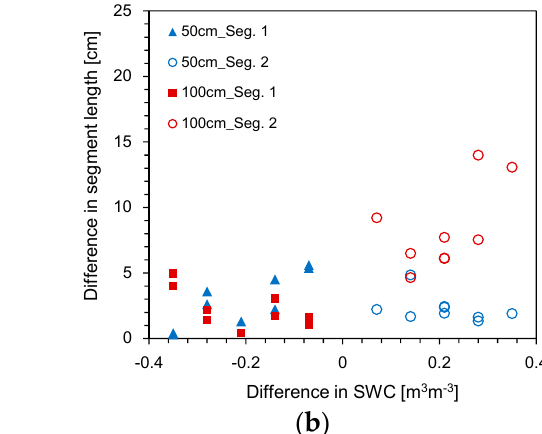
( b ) Figure 13. Comparison of SWCs measured and estimated with the probe lengths of: (a) 50 cm; (b) 100 cm. θ m and θ e denote the SWCs measured and estimated from HETDR, respectively. Table 4. Values of the slope of the linear relationship for SWCs measured and estimated at each segment. Probe length